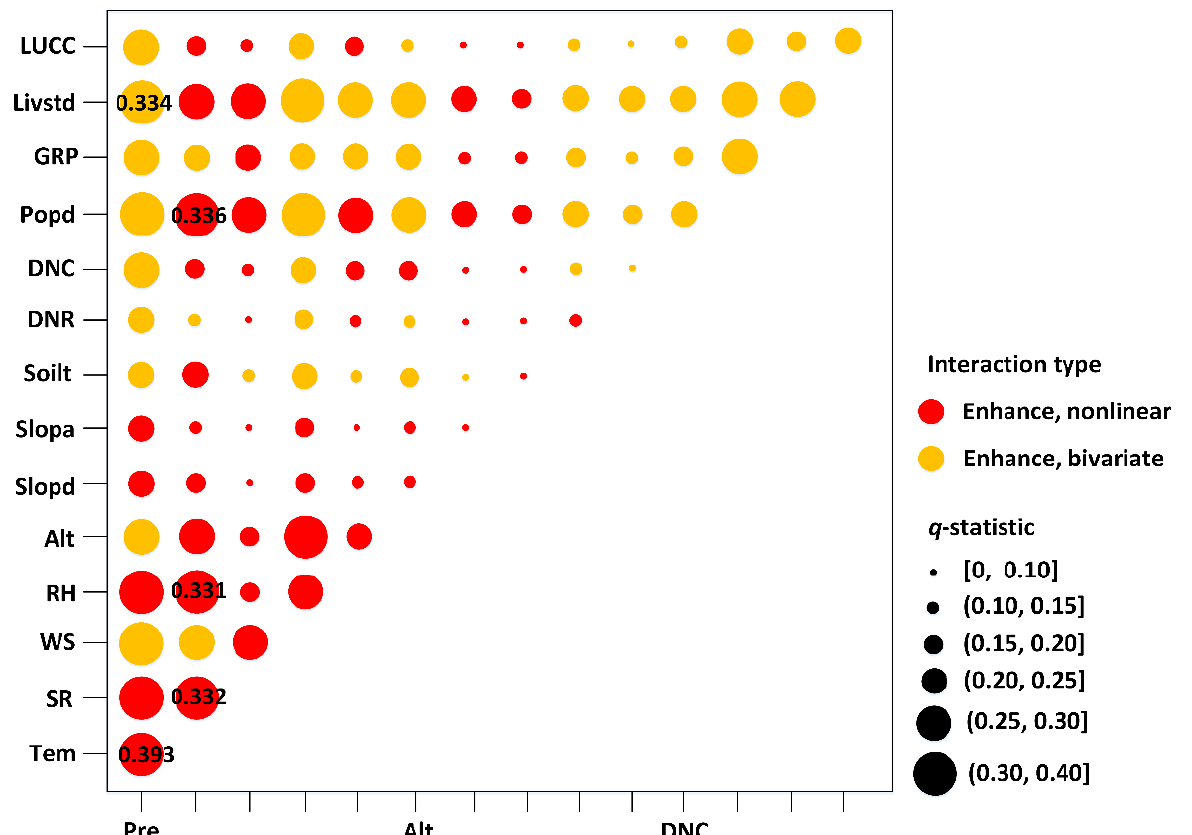
Figure 8. Influences of the interactions between two factors. Pre: precipitation; Tem: air temperature; SR: solar radiation; WS: wind speed; RH: relative air humidity; Alt: altitude; Slopd: slope; Slopa: slope aspect; Soilt: soil type; DNR: distance to the nearest road; DNC: distance to the nearest county centers; Popd: population density; GRP: Per capita gross regional product; Livstd: livestock density; and LUCC: land use/cover change type.